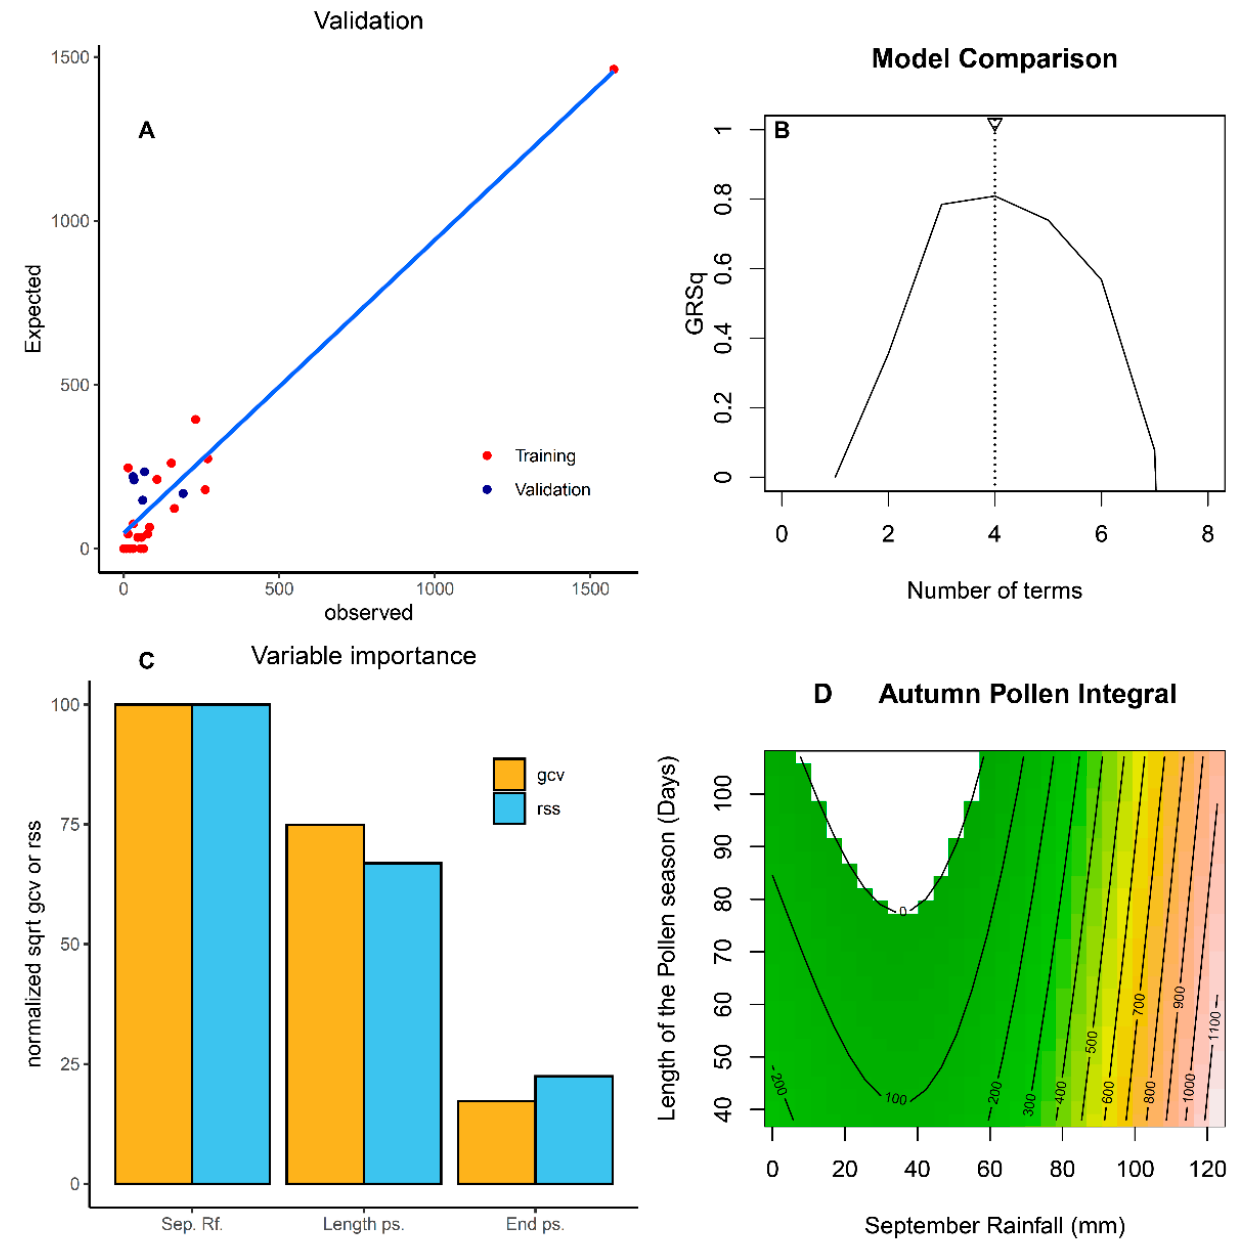
Figure 5. Multivariate adaptive regression spline (MARS) model validation of autumn pollen integral (sum of pollen grains * day/m 3 during autumn, 22 September to 21 December) ( A ). Selection of number of terms in the model based on GR 2 optimization ( B ). Variable importance of impact of GCV (generalized cross-validation) and RSS (residual sum of squares): September rainfall (Sep. Rf.); length of the pollen season (Length ps.), and end of the pollen season (End ps.) ( C ). Combined impact of September rainfall and length of the pollen season on autumn pollen integral for a general- ized additive model (GAM) with R-sq: 0.70 and 73.6% of deviance explained with only those two parameters ( D ).